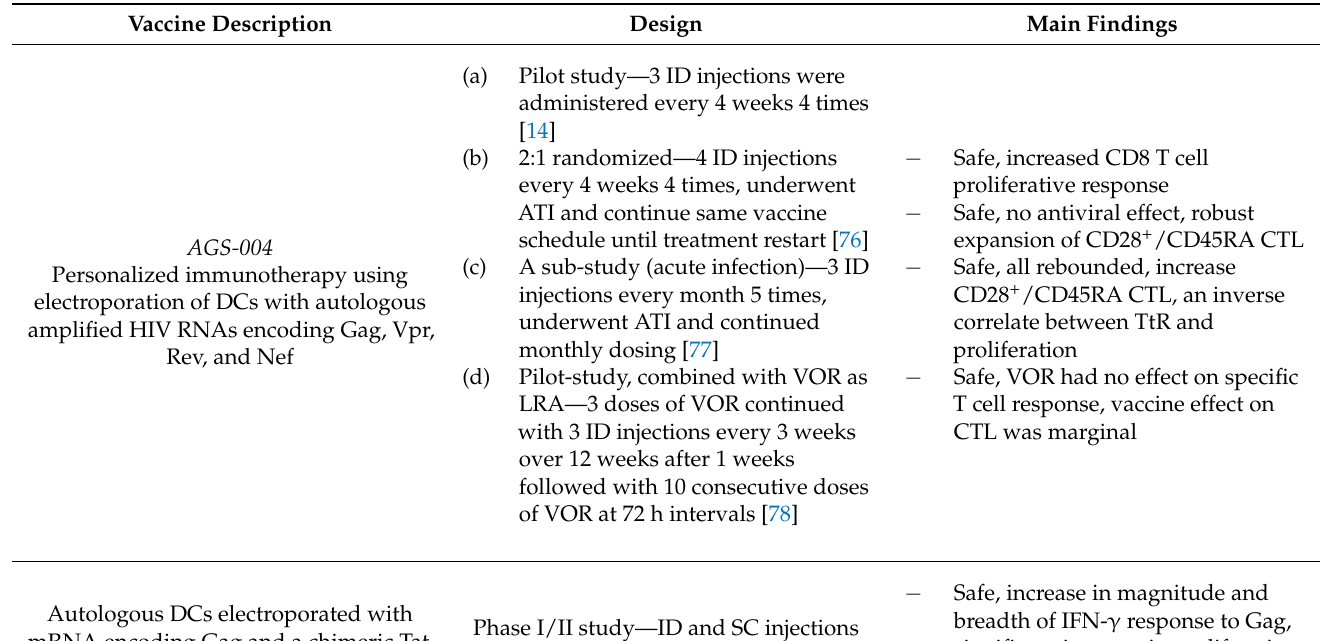
Table 2. Clinical trials of mRNA therapeutic vaccines against